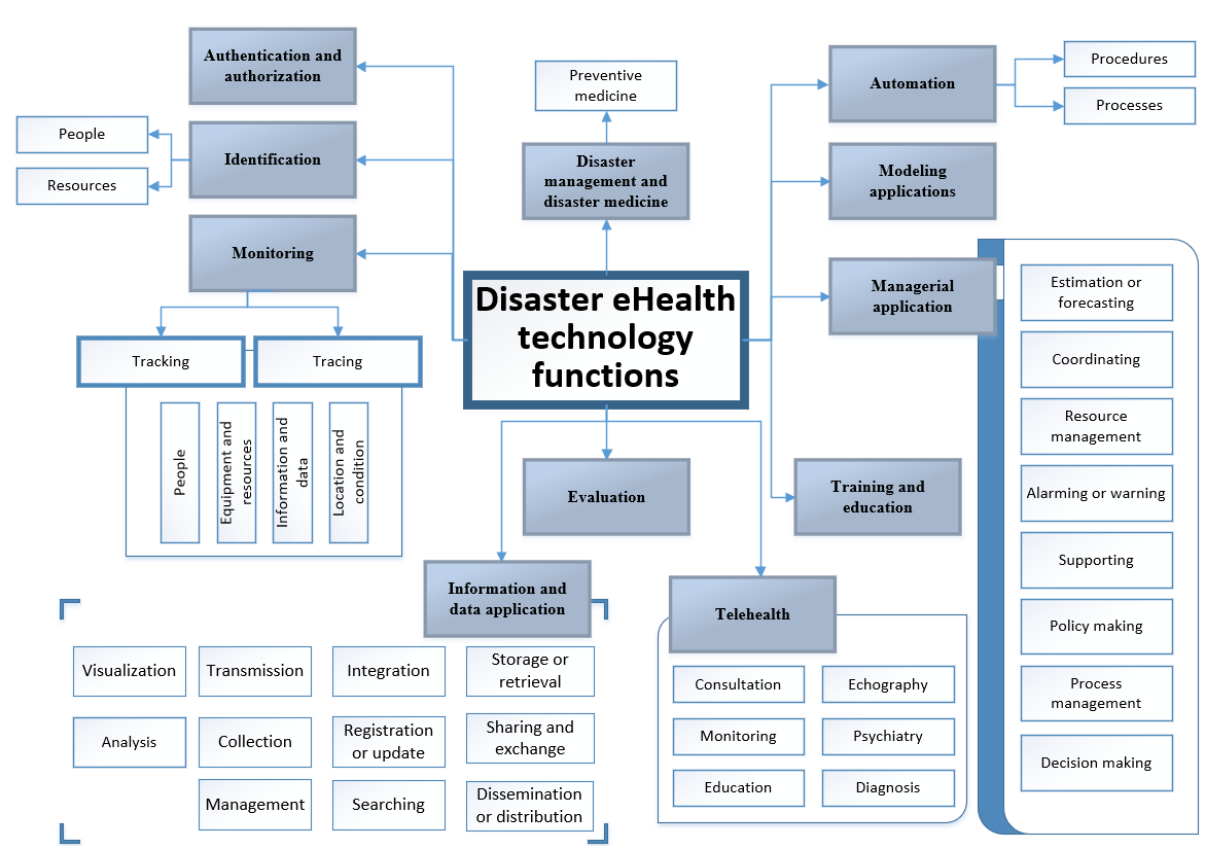
Figure 7. Technology functions within Disaster